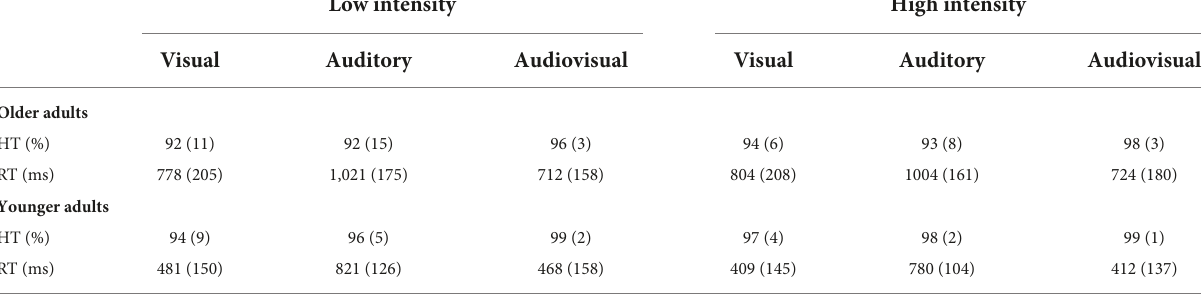
TABLE 1 Mean response times and hit rates for younger and older adults under high-intensity and low-intensity conditions. Low intensity High intensity Visual Auditory Audiovisual Visual